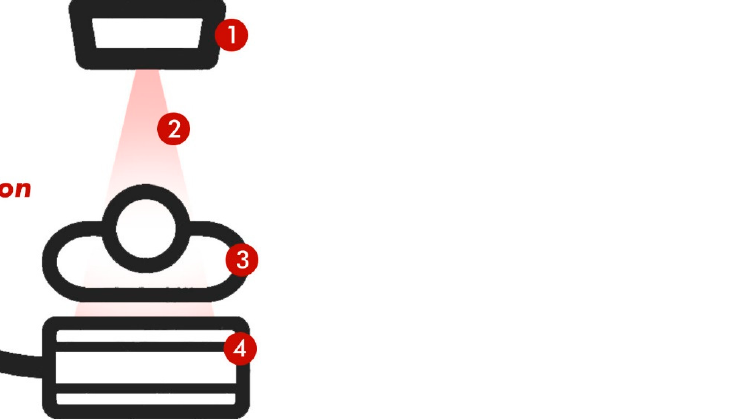
Figure 2. The X-ray tube: (1) shield, (2) electron filament, (3) target, (4) X-ray radiation beam, and (5) window. GMDH Neural Network In recent years, researchers have used mathematical models called artificial neural networks to help them understand how radiation interacts with tissue [18–31]. Moreover, the strong mathematical tool of numerical computing [32–38] has been employed to solve various engineering challenges, most notably in the field of artificial networks [39–44]. One of the intelligent methods for solving complex and nonlinear problems was devel- oped in 1968 by M.G. Ivakhnenko and named GMDH [45]. In fact, these algorithms create self-examination methods with prediction, classification, control synthesis, and system debugging capabilities. The characteristics of the network structure, including the number of layers, the number of important input features, and the ideal network configuration, were all detected automatically using Ivahnenko’s method. This method presumes that Kolmogorov–Gabor polynomials of higher order determine the system’s input and output equations.